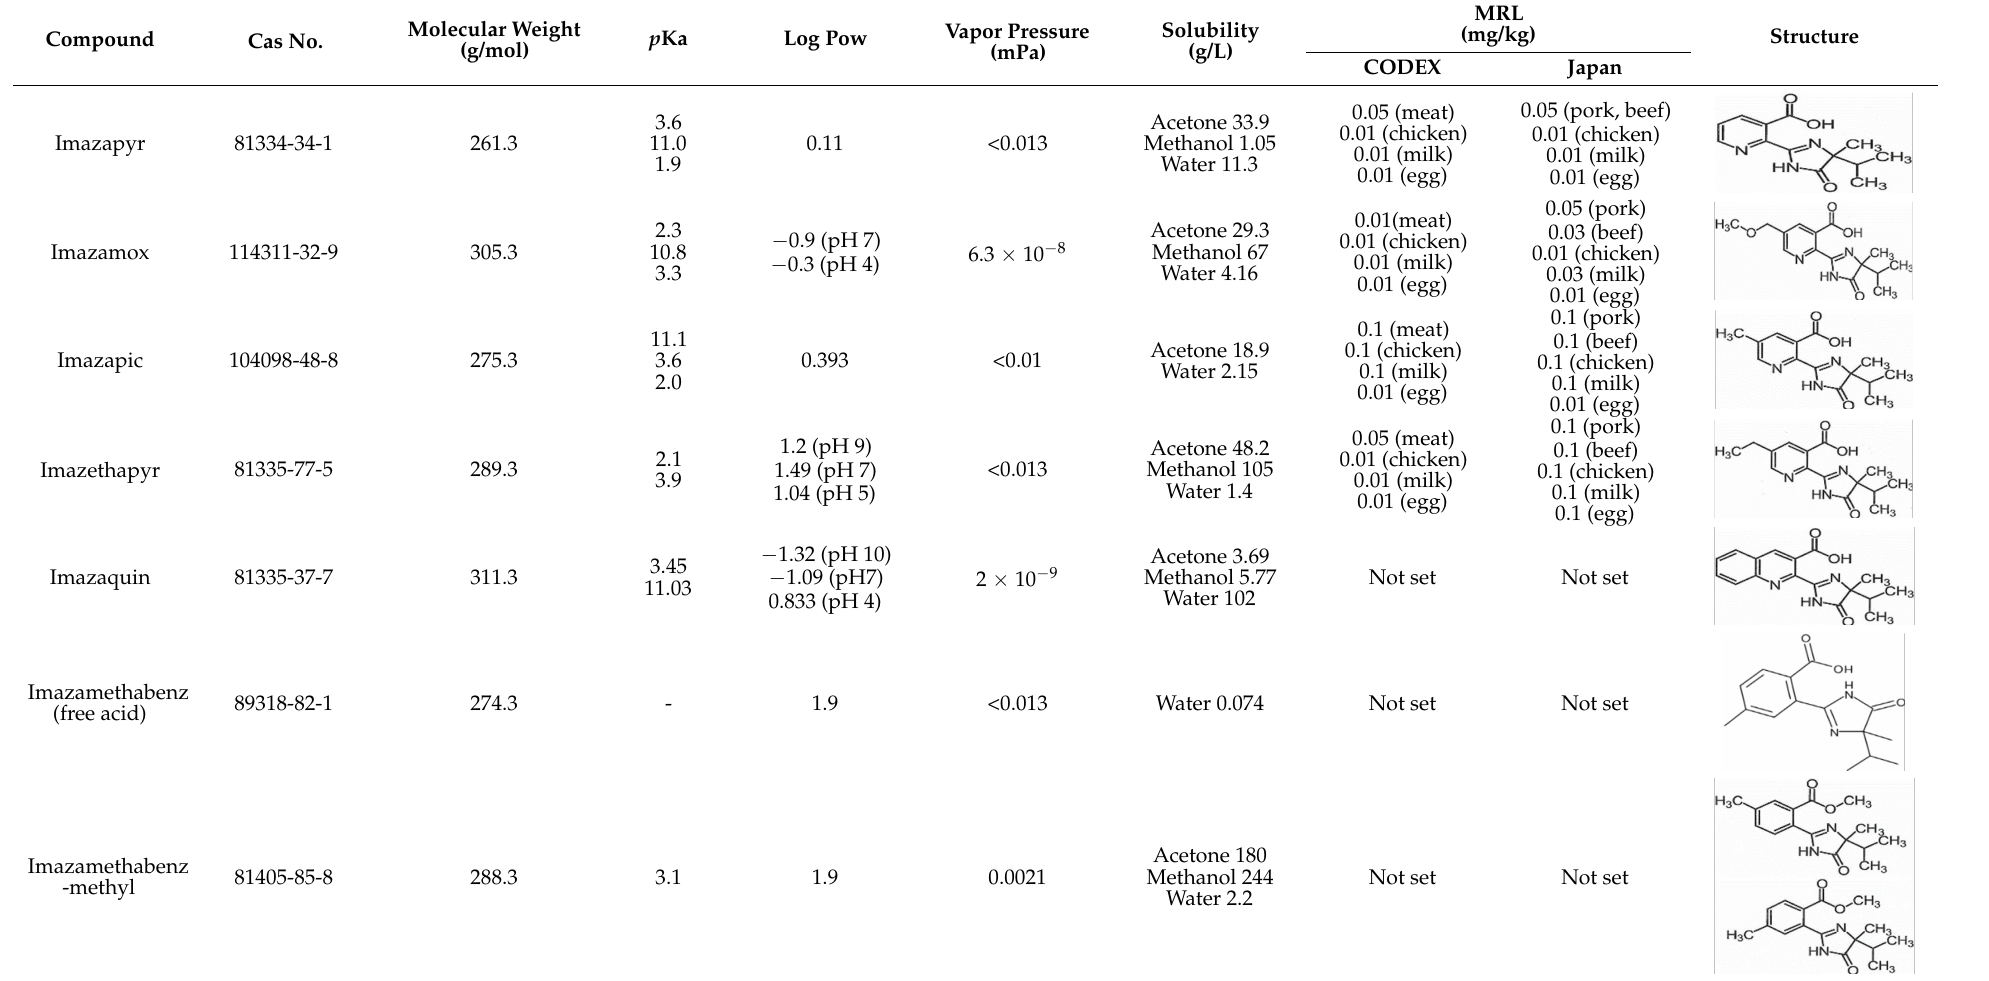
Table 1. Physico-chemical properties of imidazolinone